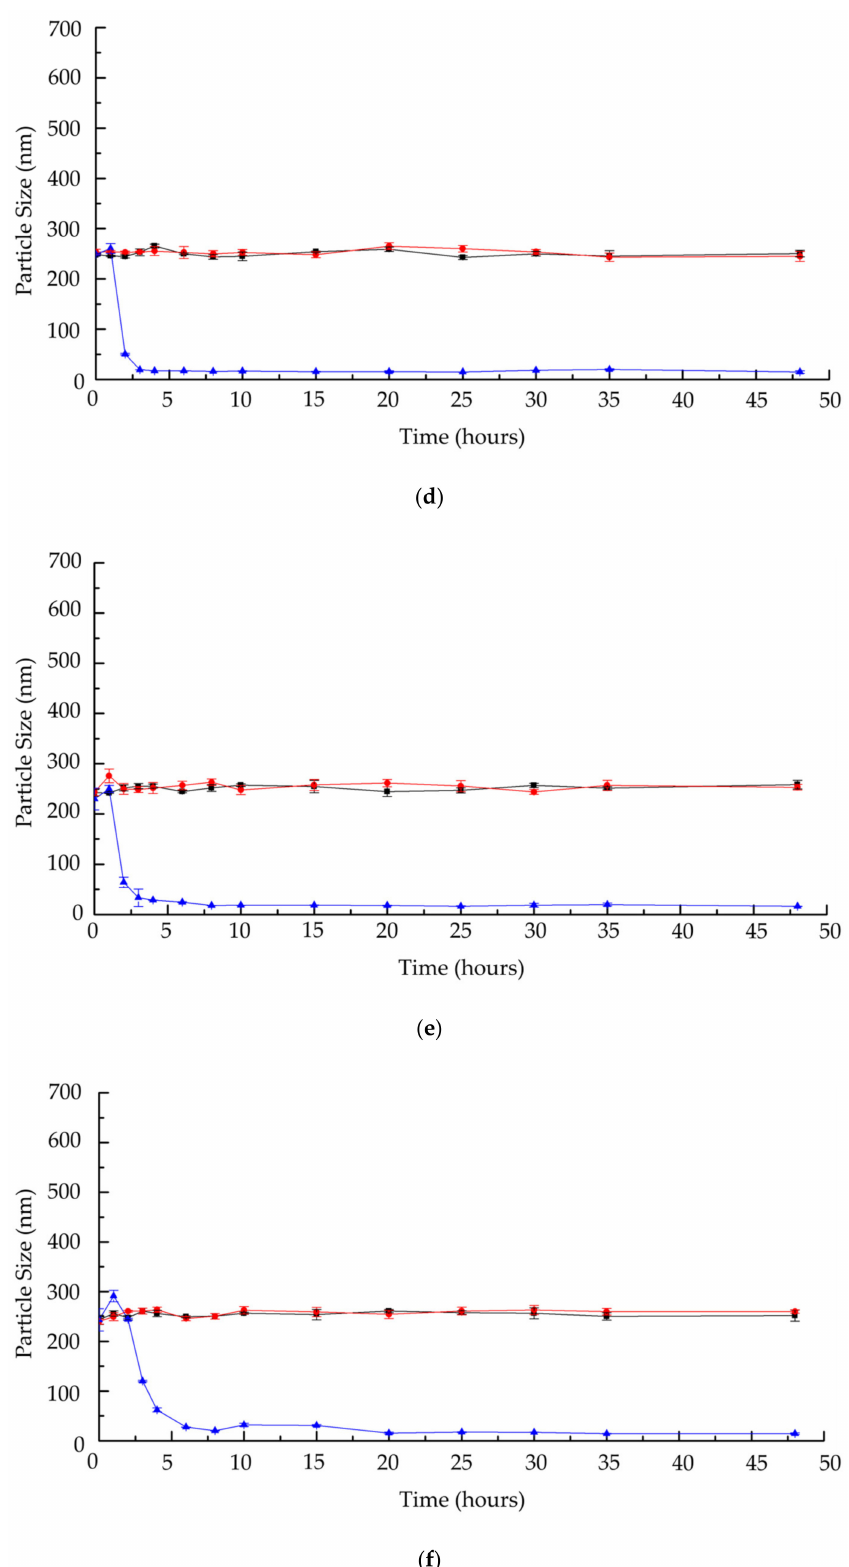
Figure 8. Characterization of the nanohydrogel redox responsiveness by particle size measurements using DLS. The measurements were performed in triplicate. ( a ) NanoC_24; ( b ) NanoC_48; ( c ) NanoC_72; ( d ) NanoS_24; ( e ) NanoS_48 and ( f )